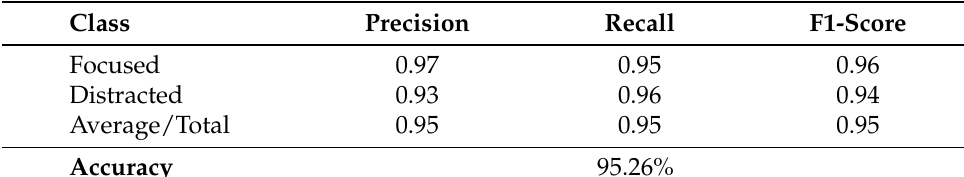
Table 2. Report of the model